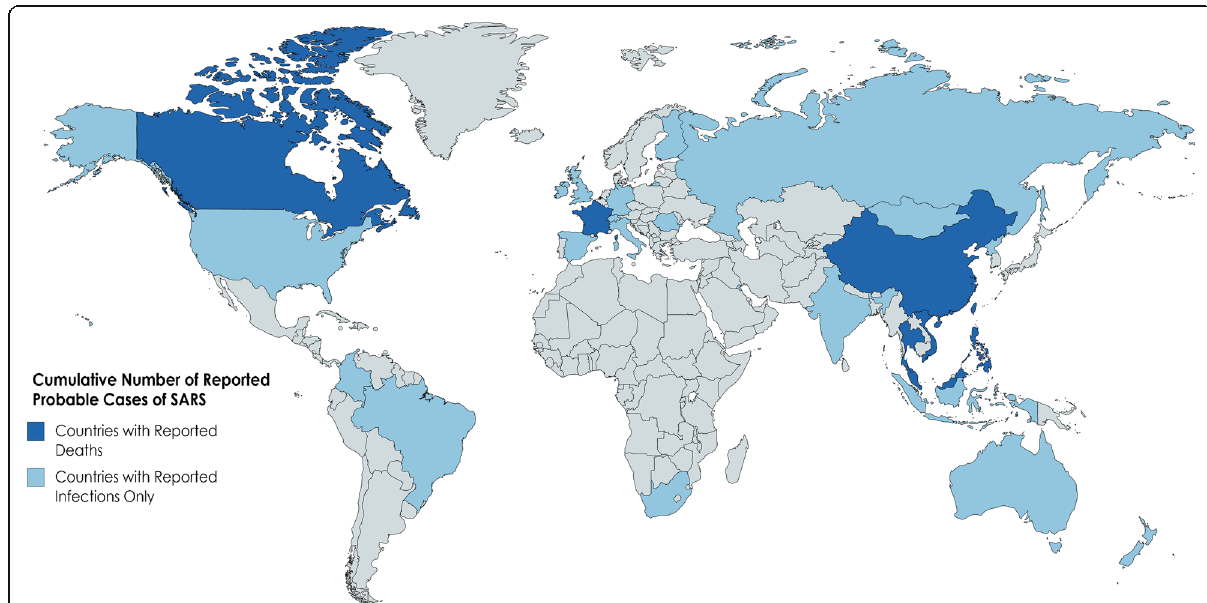
Fig. 4 Cumulative number of reported probable cases of SARS based on data from Nov 1, 2002, to July 11, 2003 (source: WHO). Depicted here are countries with reported deaths and infections versus reported infections and no deaths. Countries of high prevalence IDA (see Fig. 1) in SSA were relatively virus free